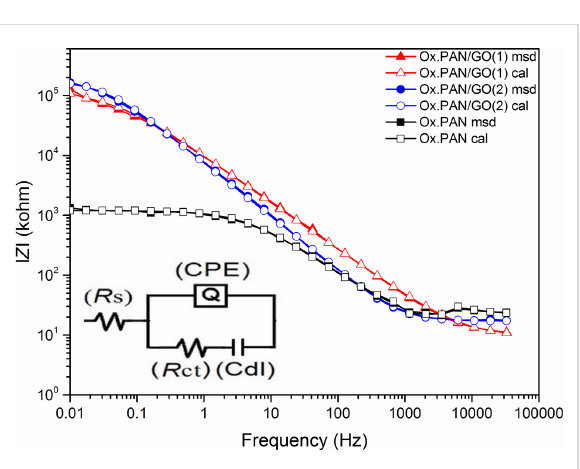
Figure 14: Bode magnitude plots of oxidized PAN nanofiber webs and GO-containing oxidized PAN nanofiber webs (inset shows the electro- chemical equivalent circuit).